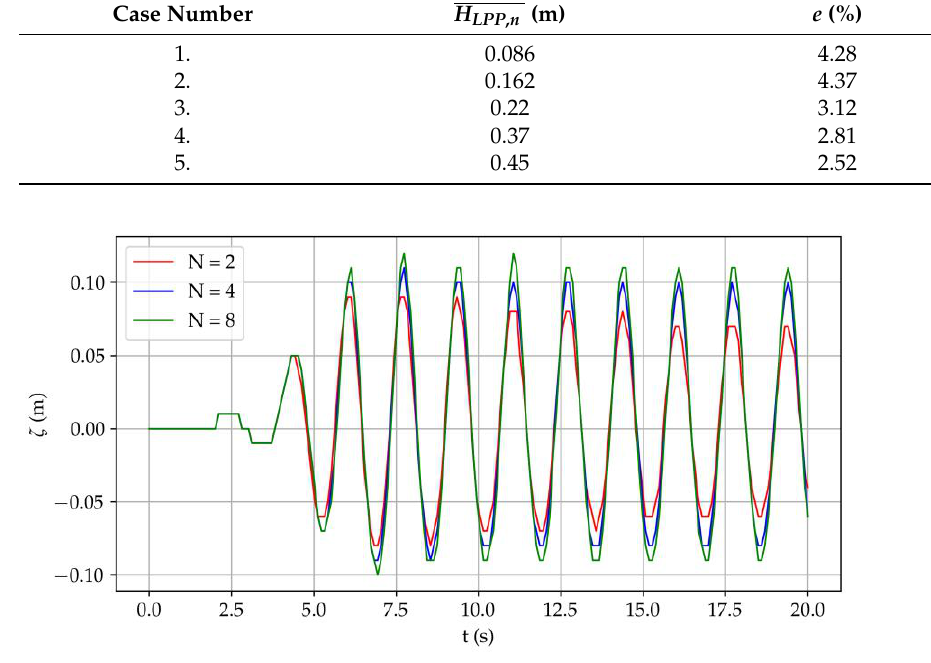
Figure 7. Influence of a number of cells per wave height, N , on wave dissipation for case 3, as defined in Table 1. Table 6. Wave propagation errors due to temporal discretization for case 3. Table 5. Wave propagation errors due to spatial discretization with eight cells per wave height.